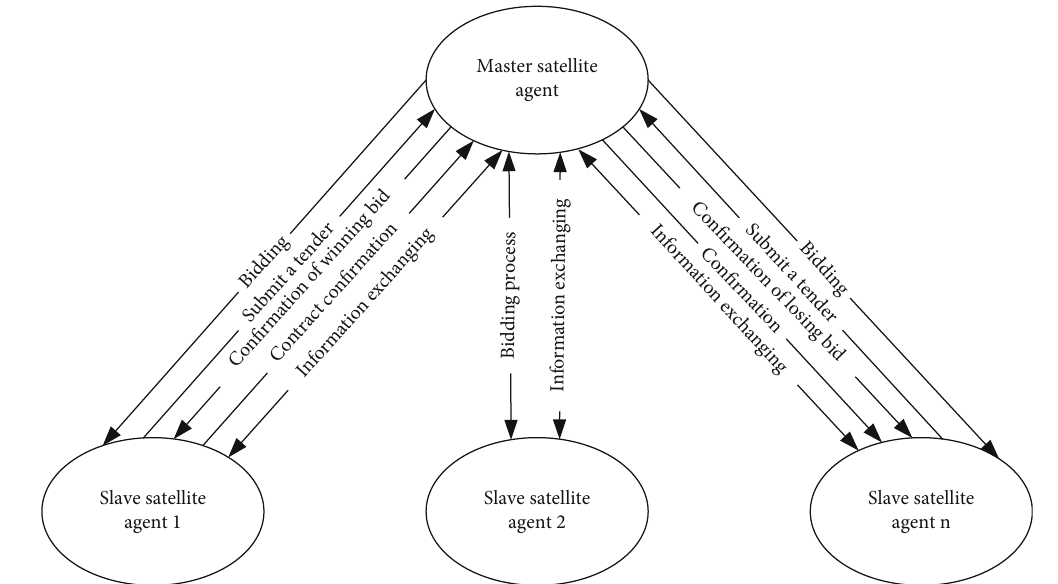
Figure 5: Task negotiation and allocation process based on contract net algorithm.